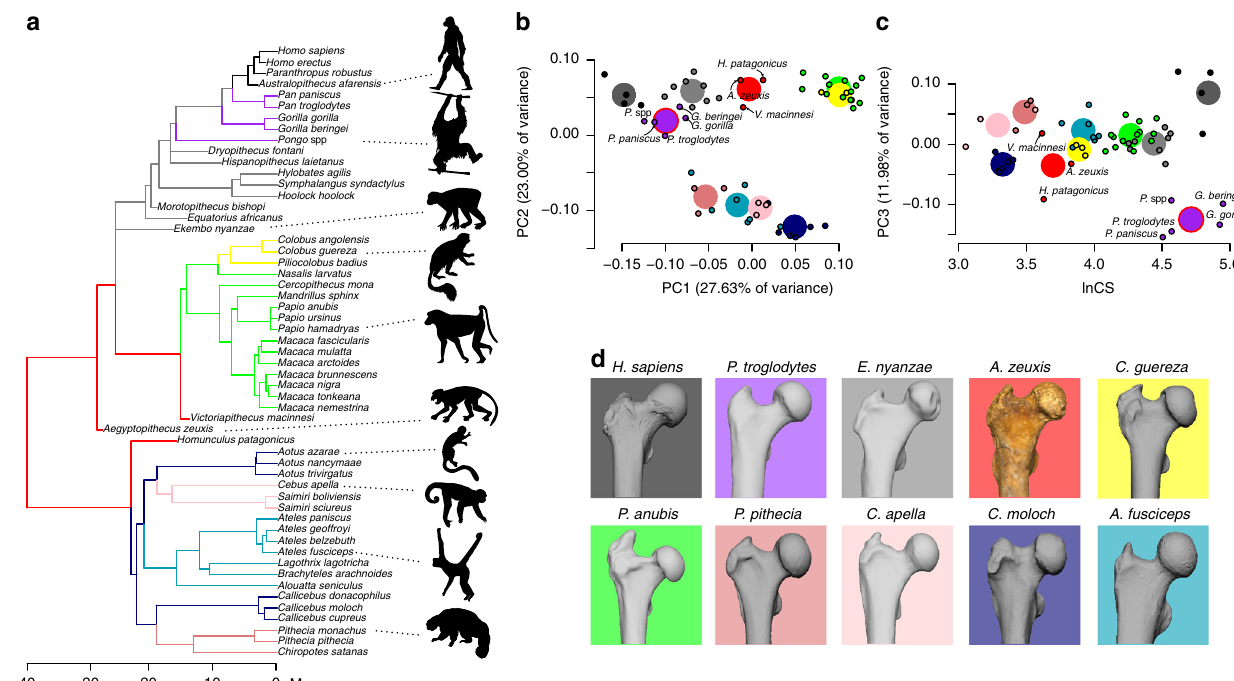
Fig. 3 Adaptive regimes in the evolution of anthropoid proximal femur form. a Time-calibrated chronometric tree depicting the estimated phylogenetic history of adaptive peak shifts during anthropoid proximal femoral shape evolution (each colour represents a different evolutionary regime). b , c Morphospaces showing the estimated adaptive optima (large circles) and species (small circles) evolving under each evolutionary regime in a . A convergent optimum is marked with a red outline. The shape changes associated with each axis are similar to those depicted in Fig. 2 (although with a reversed PC2). Supplementary Fig. 4 depicts the evolutionary history of catarrhine femoral differentiation along the fi rst three PC axes. d Morphological comparison of selected femora from each of the evolutionary regimes (scaled to similar mediolateral size). The silhouettes of the primates in a illustrate the selected primates of each regime. They were downloaded from www.phylopic.org and are licensed for free use in the Public Domain without copyright. Exceptions are the silhouettes for Cebus apella (credit to Sarah Werning and available for use under CC BY 3.0 license), Ekembo nyanze (credit to Nobu Tamura and modi fi ed by T. Michael Keesey, under CC BY-SA 3.0 license), Aegyptopithecus zeuxis (credit to Mateus Zica and modi fi ed by T. Michael Keesey, under CC BY-SA 3.0 license). The silhouette of Pongo was custom made. Source data are provided as a Source Data fi